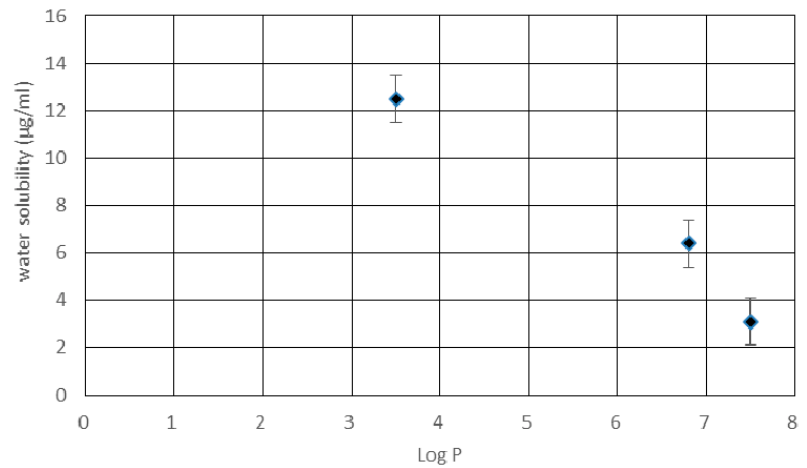
Figure 2. Relationship between Log P and water solubility of IDE (Log P 3.49), IDELIP (Log P 6.83), and IDETRL (Log P 7.52).